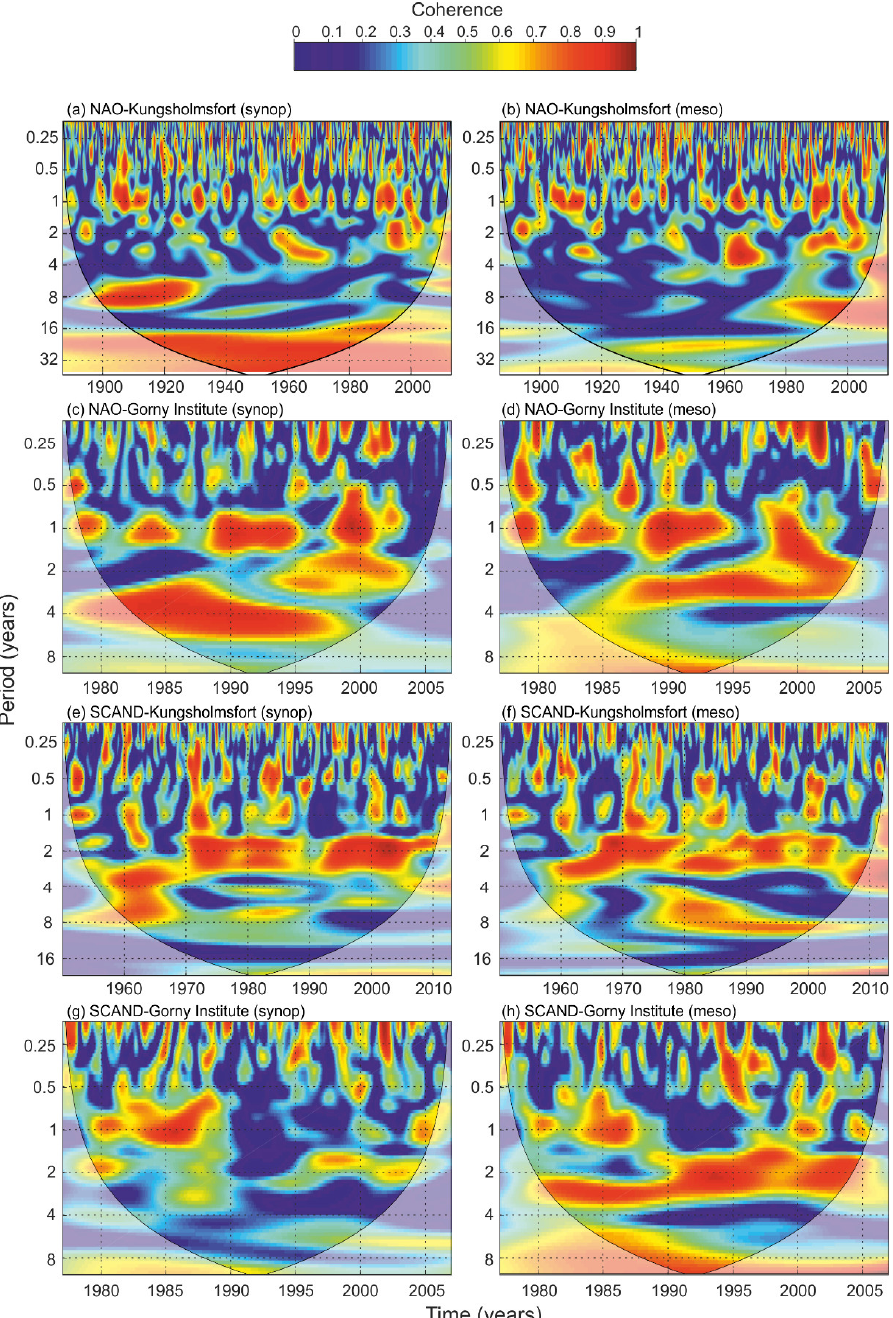
Figure 10. Wavelet coherence of ( a – d ) NAO and ( e – h ) SCAND monthly values with ( a , c , e , g ) σ 2 syn and ( b , d , f , h ) σ 2 mes at ( a , b , e , f ) Kungsholmsfort and ( c , d , g , h ) the Gorny Institute. Contours are wavelet squared coherencies. In all panels, the black thin line and the lighter shaded picture show the cone of influence of the edge effects that might distort the coherence.